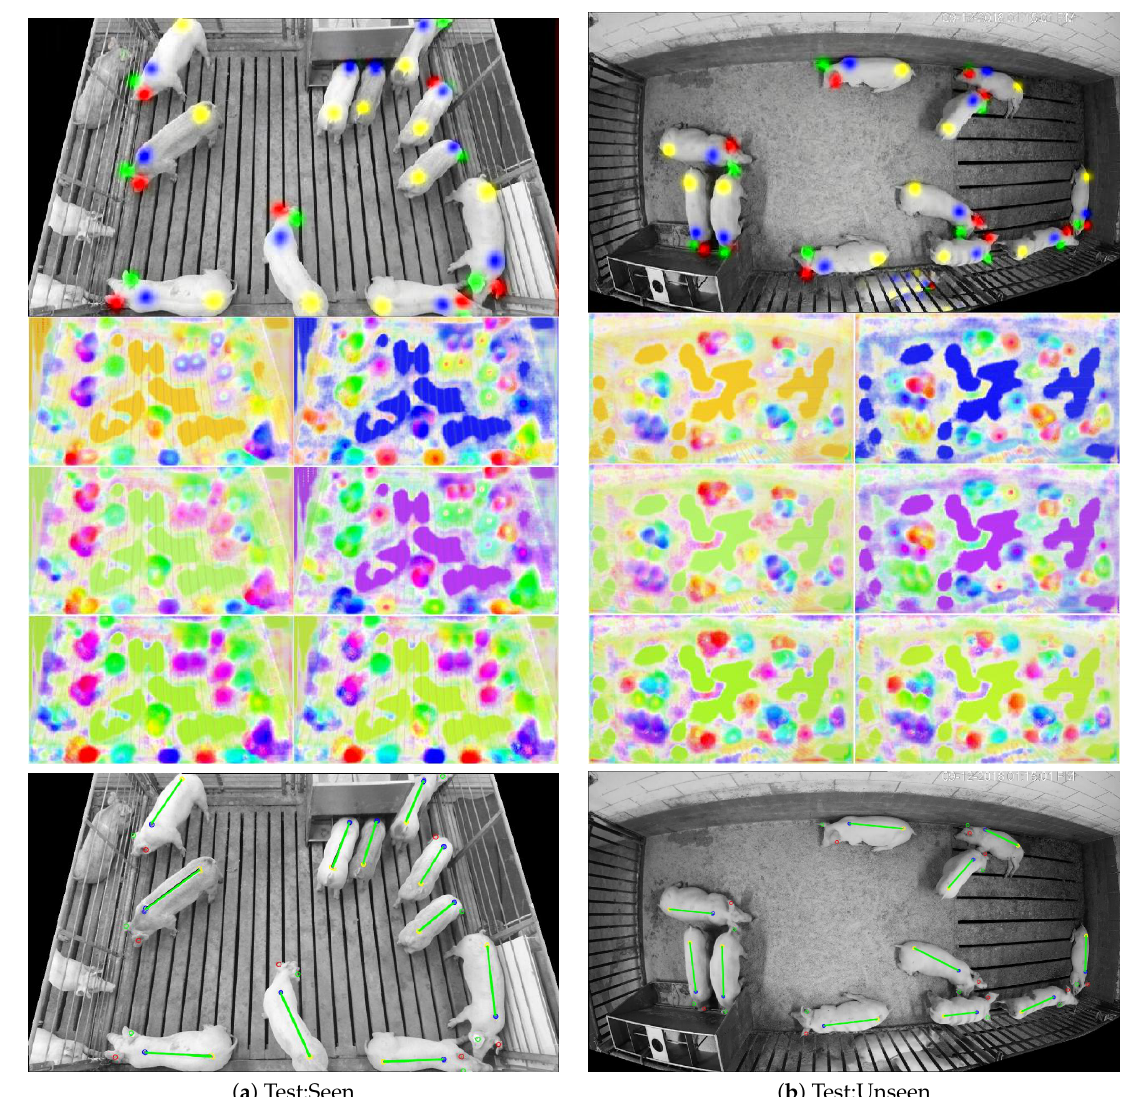
Figure 11. Examples of successful instance detection from both the test:seen set ( a ) and the test:unseen set ( b ). The top images depict the first four channels of the neural network output. The middle image composed of six sub-images depicts the color-coded vector associations from the last 12 channels of the neural network output. The bottom images depict both ground truth locations and estimates using the following color coding: false negative (blue), and true positive (green). Note that these images depict 100% successful detections, so only true positives are